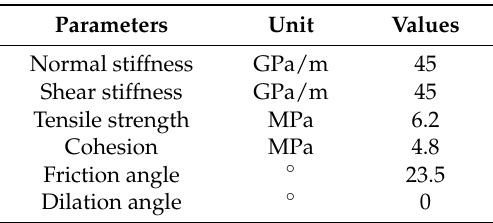
Table 2. Fault properties assigned for the proposed